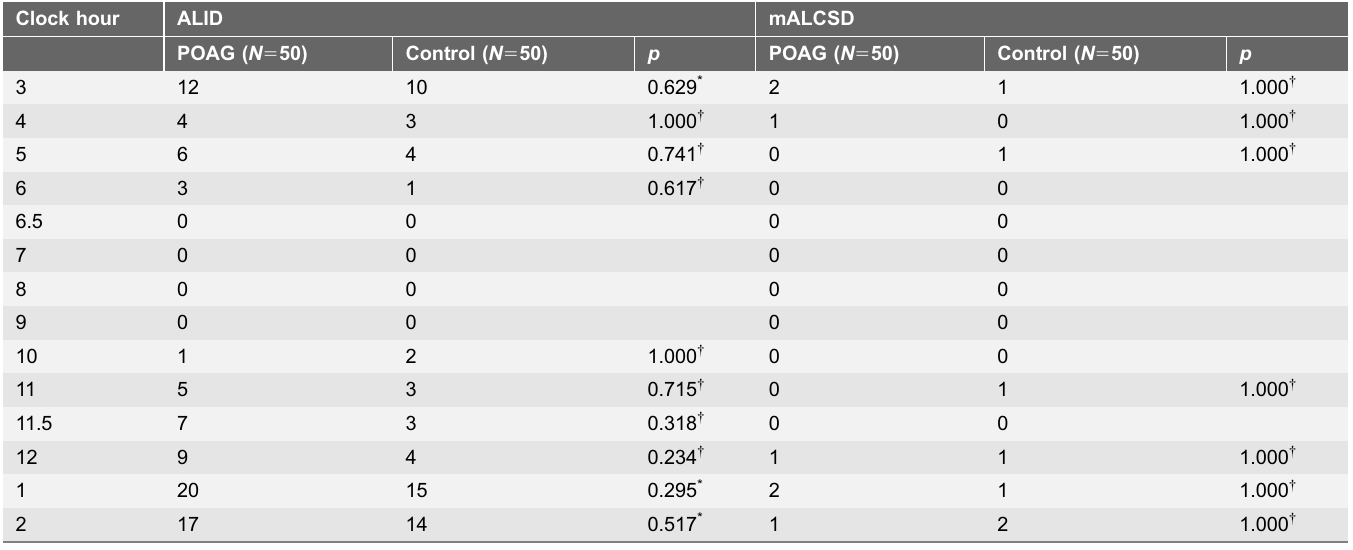
Table 2. Number of cases for which either the anterior lamina cribrosa insertion distance (ALID) or the marginal anterior laminar cribrosa depth (mALCSD) was not measurable in each meridian. Clock